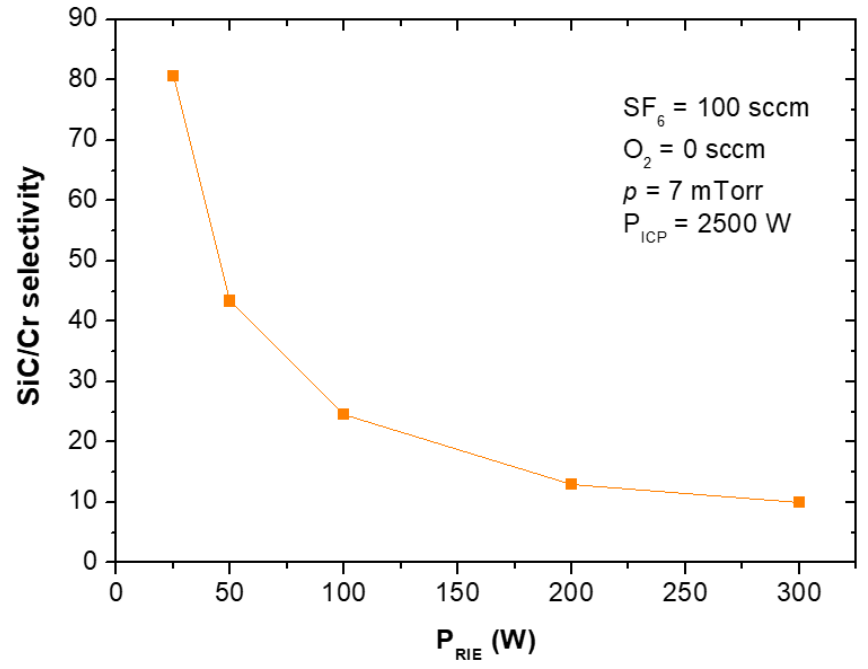
Figure 14. SiC/Cr selectivity as a function of RIE power applied. Fixed parameters are included in the inset.